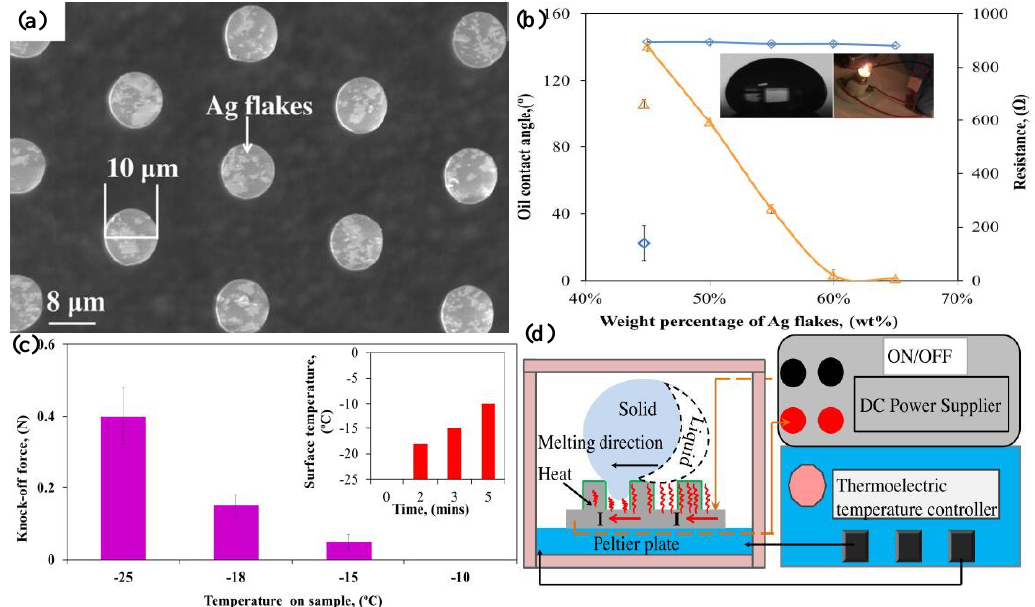
Figure 15. ( a ) SEM image of Ag flakes/epoxy resin composite micropillars. ( b ) Effects of Ag content on superoleophobicity and electrical resistance. ( c ) Relationship between knock-off force and surface temperature. ( d ) The Joule heating effect [229]. Reproduced with permission from Elsevier.